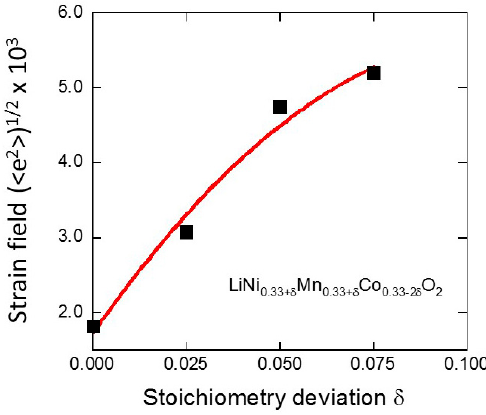
Figure 18. Evolution of the strain (< e 2 >) 1/2 with the deviation from stoichiometry δ in LiNi 0.33+ δ Mn 0.33+ δ Co 0.33-2 δ O 2 samples synthesized by the sol-gel method.